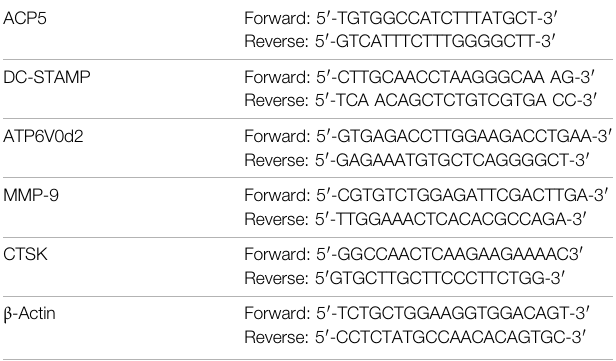
TABLE 1 | The primer sets used are as